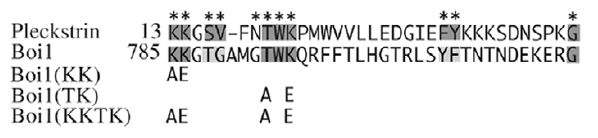
Figure 4 Sequences from a PH domain of pleckstrin and from different versions of Boi1. Asterisks indicate those posi- tions in a segment of pleckstrin's N-terminal PH domain that are implicated in binding to PIP 2 [17]. Of these positions, those that have the same amino acid at the corresponding position in Boi1 are indicated with dark shading, and those that contain a similar amino acid are indicated with light shad- ing. The sequences of the KK, TK, and KKTK mutant ver- sions of Boi1 are represented by indicating only those amino acids in the mutants that are different from those in the cor- responding positions of the wild-type